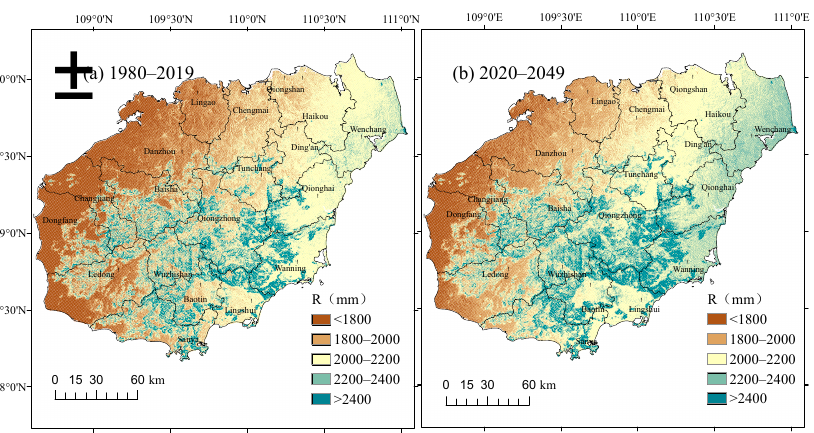
ing green orange will gradually move from the east to the central region.